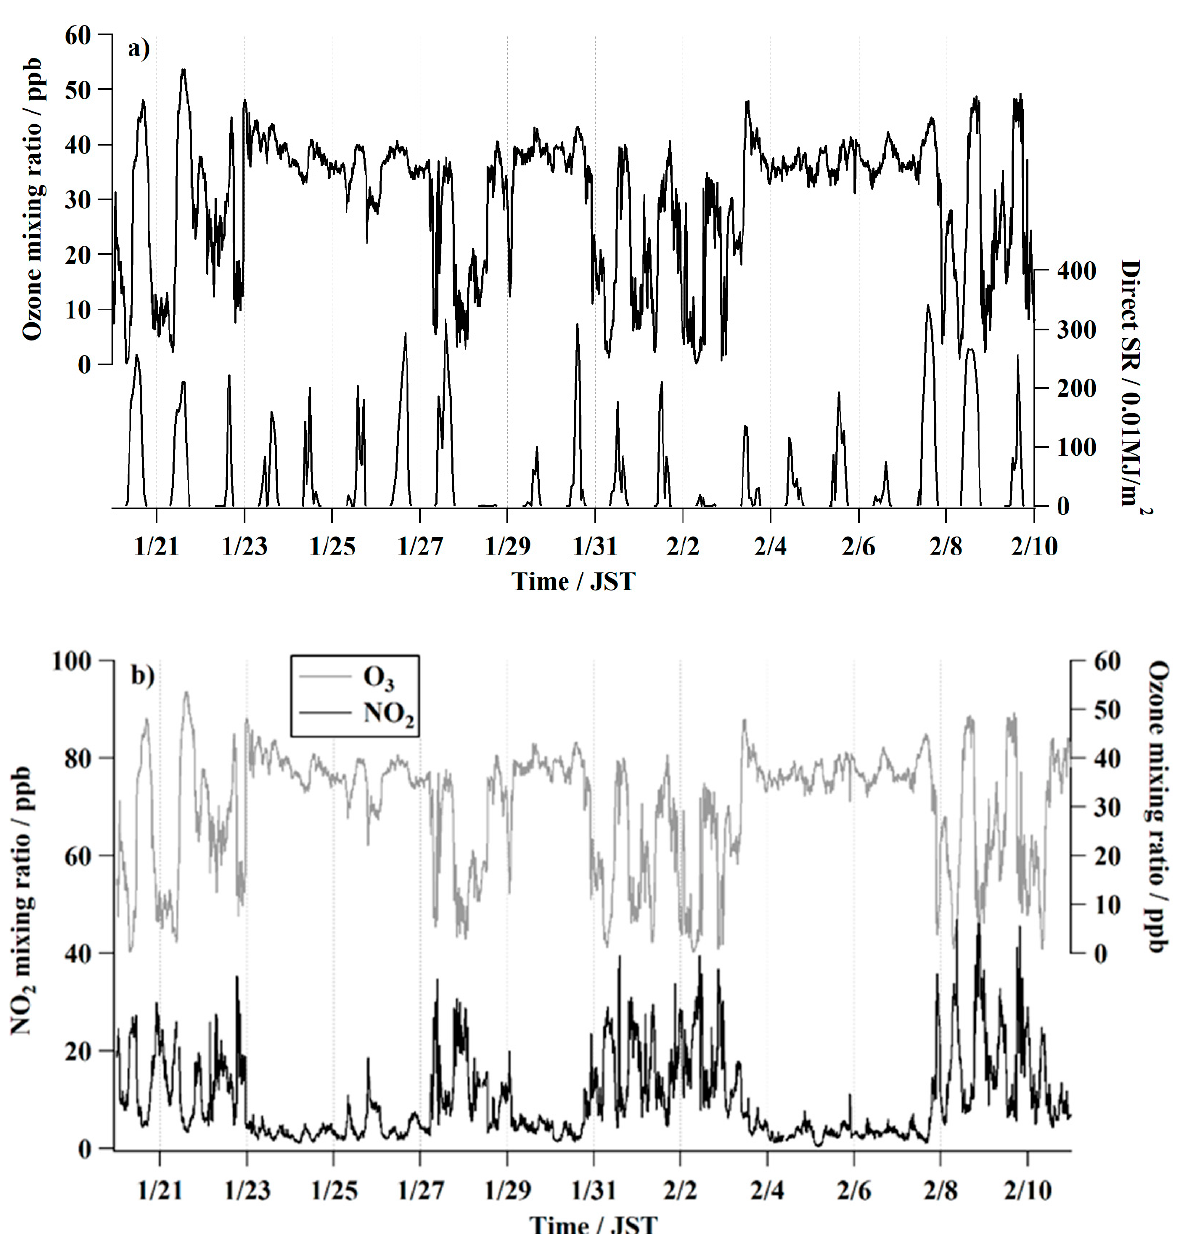
Figure 2. ( a ) Concentration (mixing ratio) of ozone and direct solar radiation in Fukuoka. ( b ) Concentration (mixing ratio) of ozone and NO 2 .